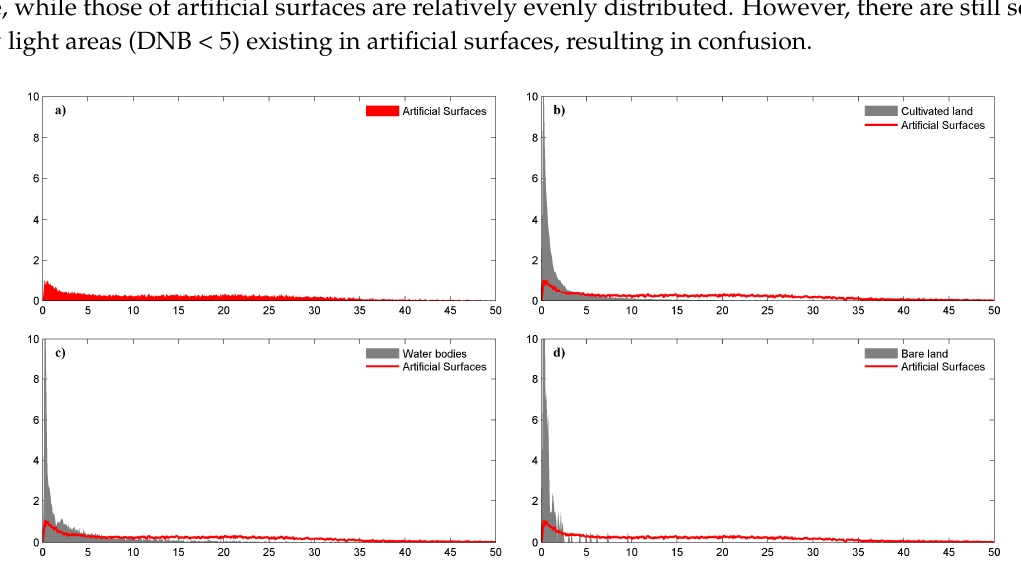
Figure 11. The distribution frequencies of the NPP-VIIRS DNB value of four easily confused land cover types: ( a ) artificial surfaces, ( b ) cultivated land, ( c ) water bodies and ( d ) bare land. The x -axis is the original NPP-VIIRS DNB value in 2012, and the y -axis is the distribution frequency. Pixels with DNB values greater than 50 nW · cm − 2 · sr − 1 are not shown.